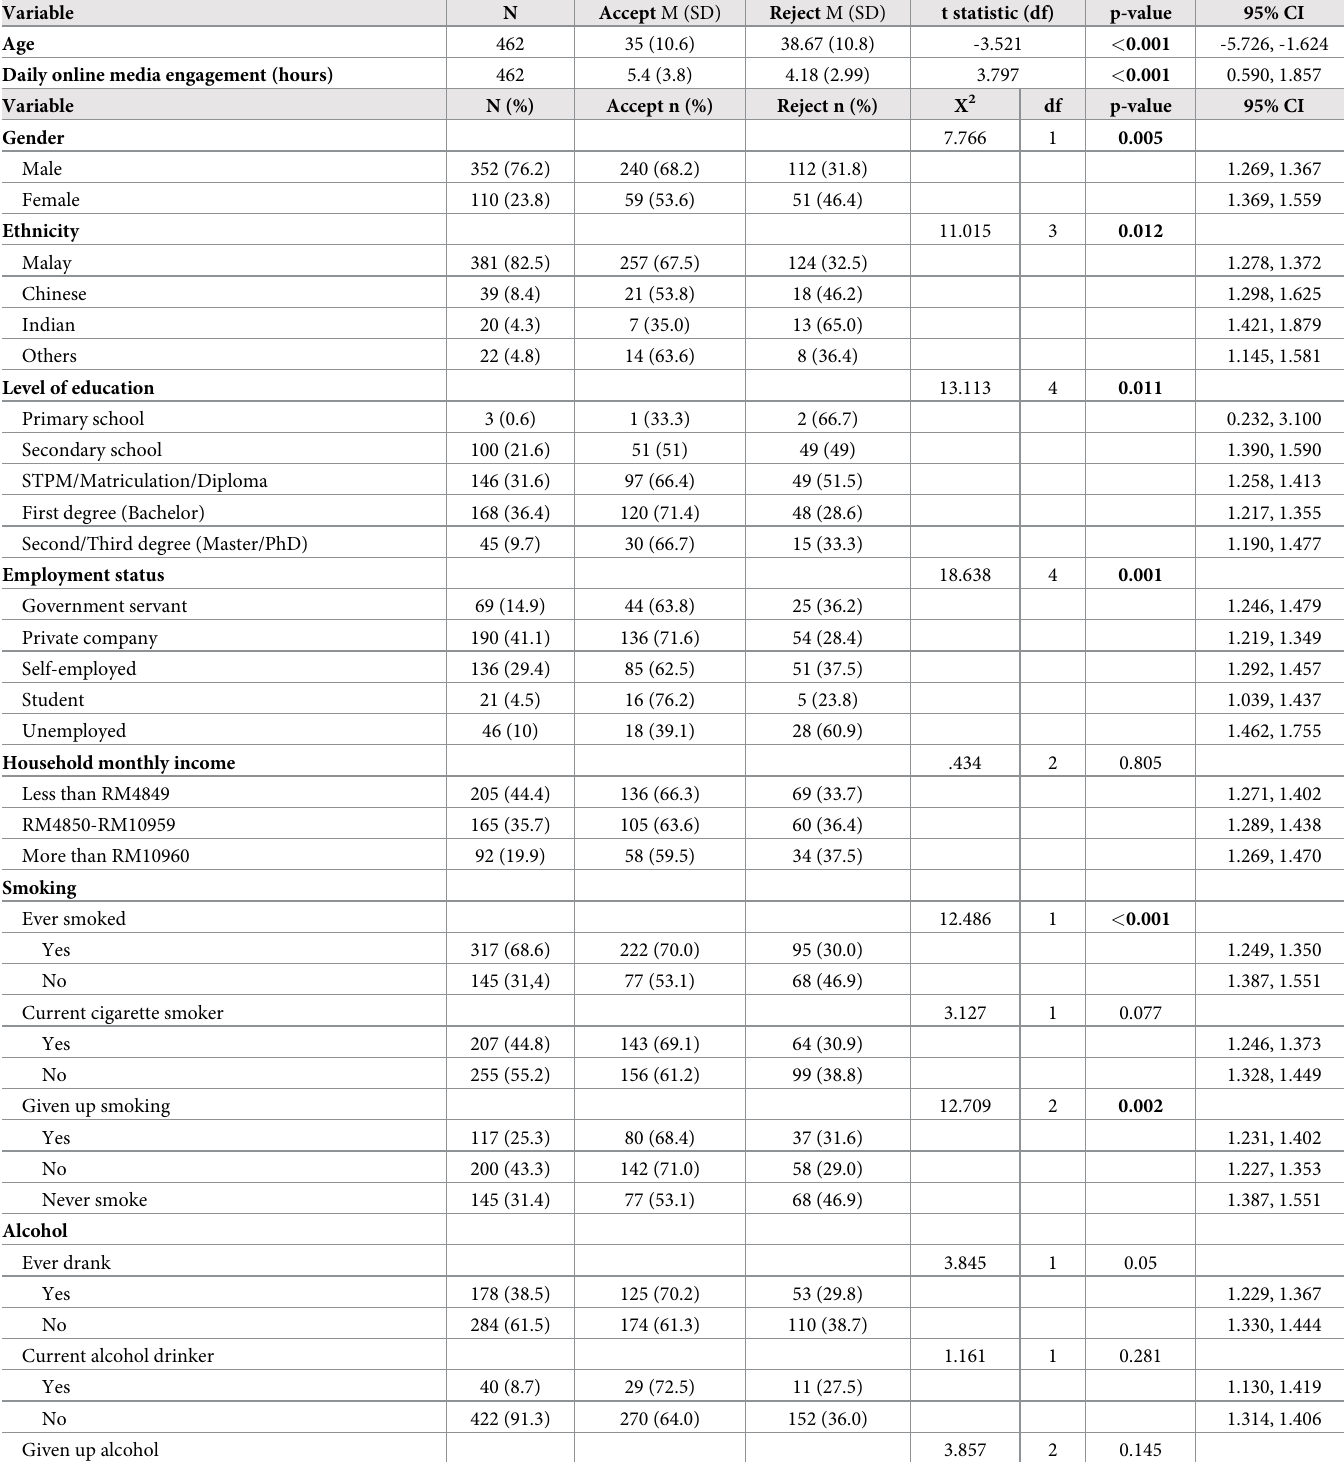
Table 4. Associations between acceptance towards decriminalization of medical marijuana and sociodemographic, socioeconomic, and lifestyle factors, and percep- tion of medical marijuana